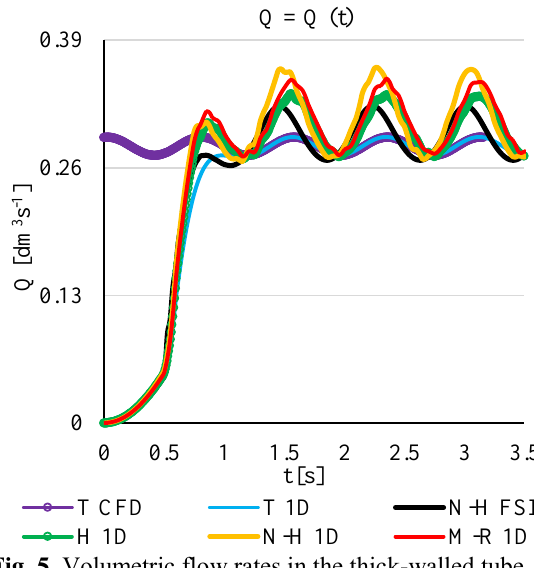
Fig. 5. Volumetric flow rates in the thick-walled tube.